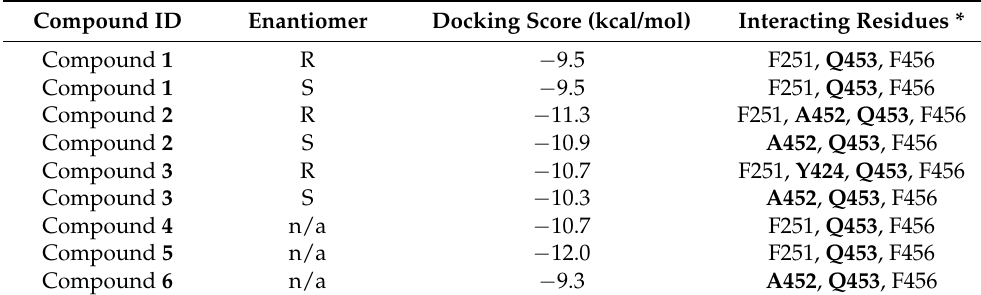
Table 1. Molecular docking and interacting residues along with the score for all the complexes and available